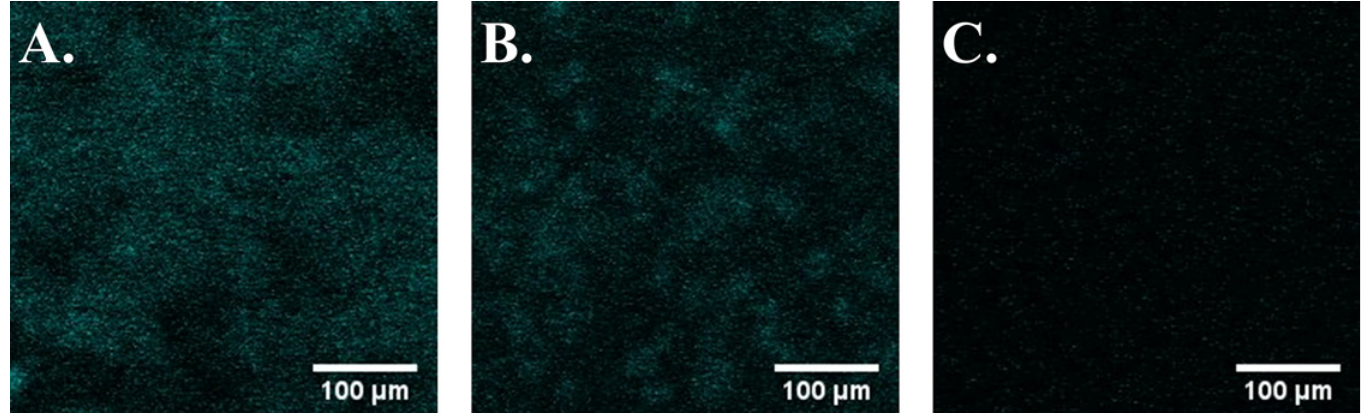
Fig 2. Fluorescent in situ hybridization images displaying Geobacter distribution. (A) On actively respired anode surface, (B) On non-actively respired surface of the same MFC, (C) On surface of control MFC. Frame size = 1.6 X 10 − 3 cm 2 .